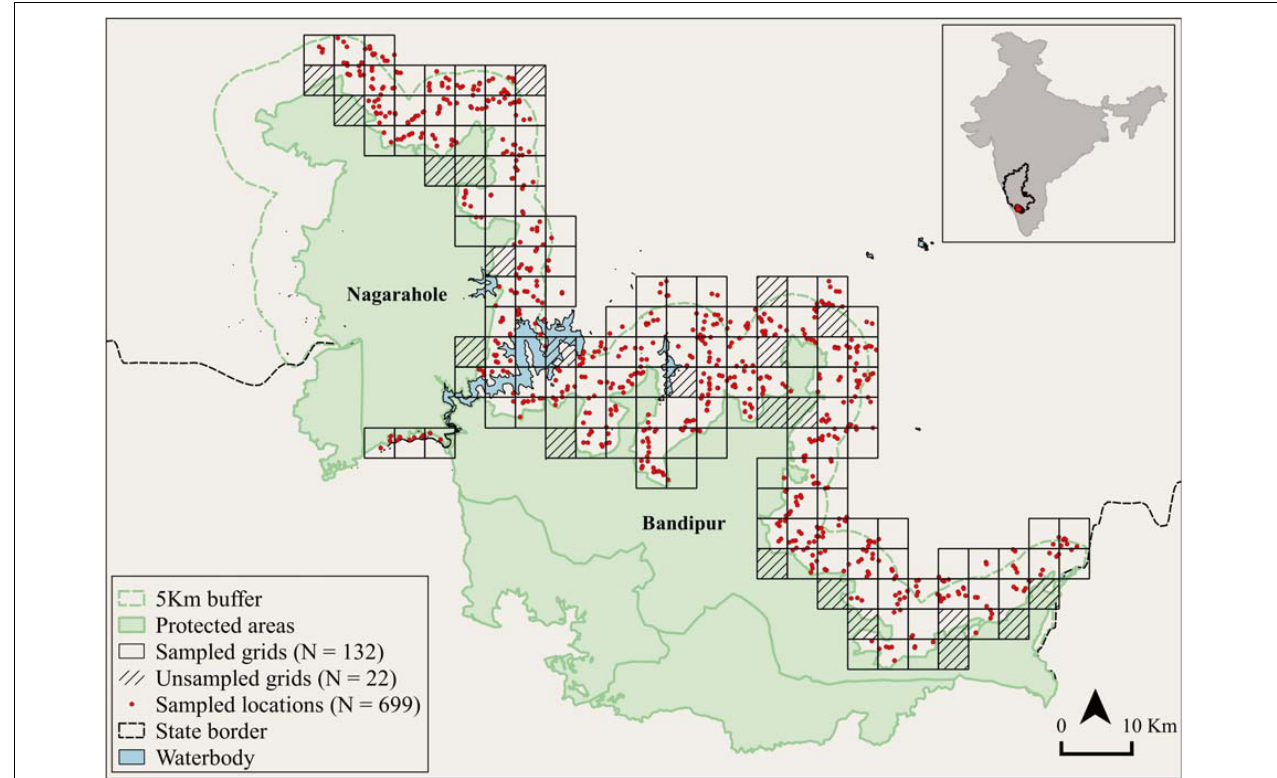
FIGURE 1 | Map of the study location with India shown in